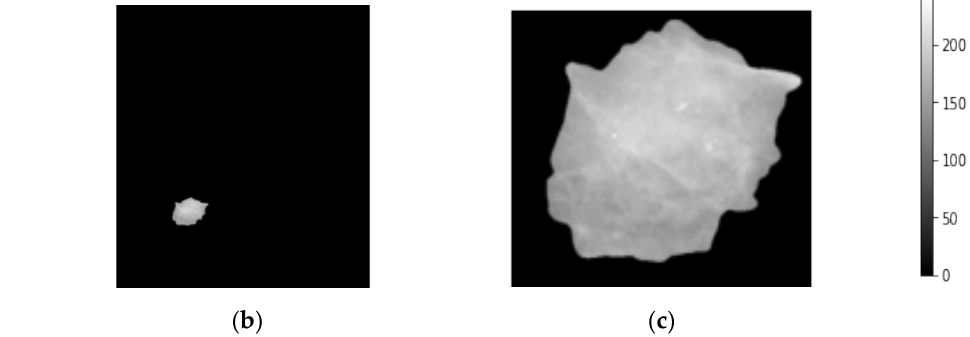
Figure 4. Patch image extraction to represent the breast region of interest, ROI. ( a ) Original mammogram, ( b ) the segmented lesion area, and ( c ) the final extracted ROI patch images.